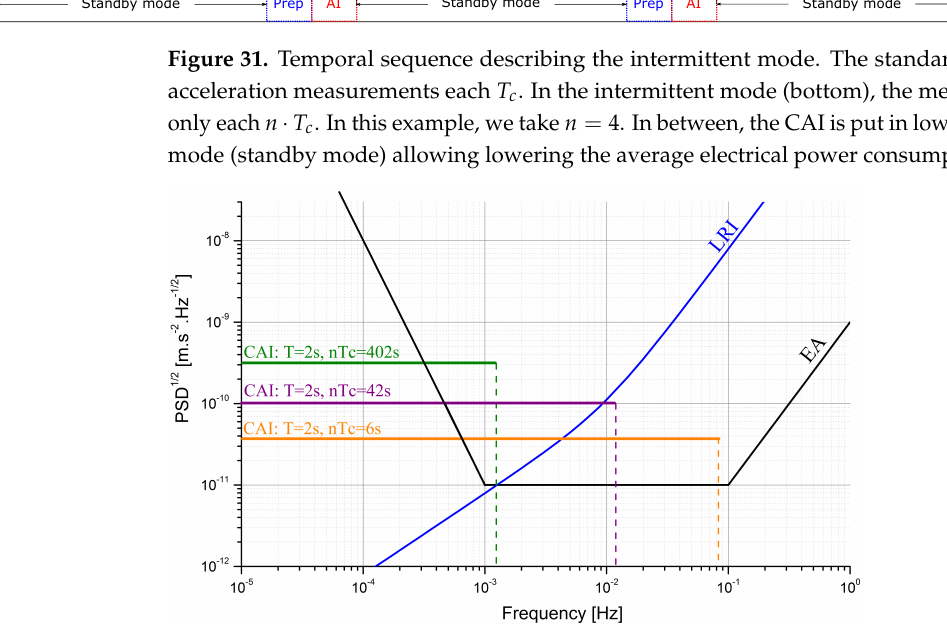
Figure 32. Evolution of the CAI noise (QPN) due to intermittent operation for an interrogation time T = 2 s and a cycling time T c = 6 s in standard mode. The orange, purple, and green curves correspond, respectively, to an effective measurement cycling time of 6 s ( n = 1), 42 s ( n = 7), and 402 s ( n =